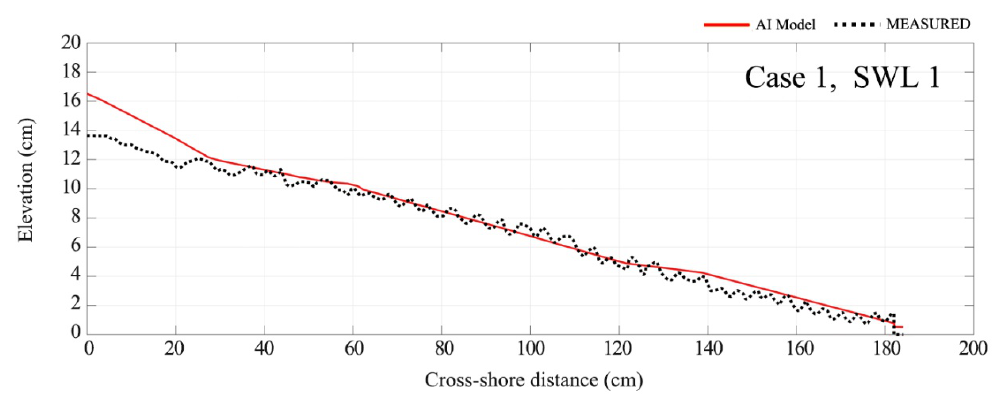
Figure 14. Case 1 SWL 1 comparison of the ANN prediction and measured from the physical test.